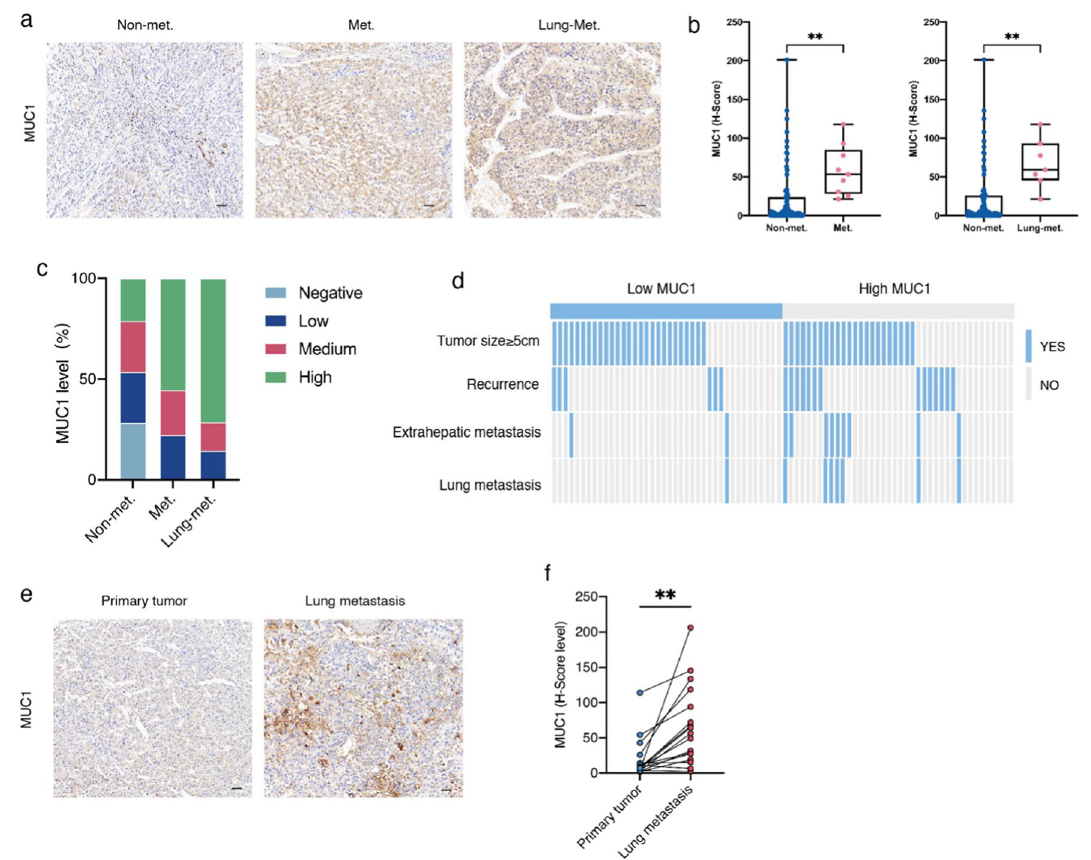
Fig. 2 MUC1 expression is significantly correlated with liver cancer lung metastasis. a – c MUC1 expression level in non-metastasis (n = 69), extrahepatic metastasis(n = 11) and lung metastasis (n = 7). (a) Representative pictures of MUC1 immunohistochemistry staining. b Com- position of MUC1 expression level in non-metastasis, extrahepatic metastasis and lung metastasis. c Comparison of MUC1 between non- metastasis and extrahepatic metastasis, non-metastasis and lung metastasis, respectively. d Clinical events of MUC1 high group (n = 40) and MUC1 low group (n = 40). e , f Comparison of MUC1 between paired primary tumors and lung metastases. e Representative pictures of MUC1 immunohistochemistry staining and f statistics chart. Scale bars, 50 μm. *P < 0.05, **P < 0.01, ***P < 0.001, by chi-squared test ( d ) and two-tailed unpaired ( c ) or paired ( f ) t